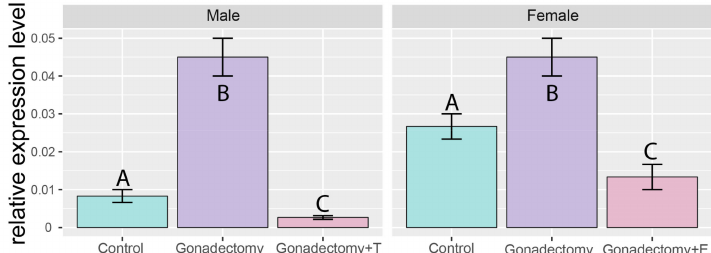
Figure 4. Effects of gonadectomy and testosterone (T) or estradiol (E) replacement on Giot1 gene expression in rat adrenals measured by qPCR method. Bars present means ± SEM ( n = 5). Statistical analysis of the data was performed by using one-way analysis of variance (ANOVA) followed by Tukey’s HSD test. Groups sharing the same letter are not significantly different according to Tukey’s HSD test.